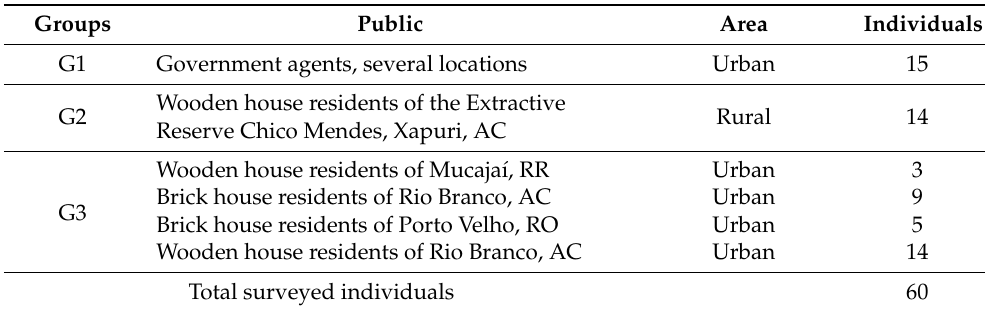
Table 2. Groups, locations, and the number of individuals surveyed with the SWOT matrix.